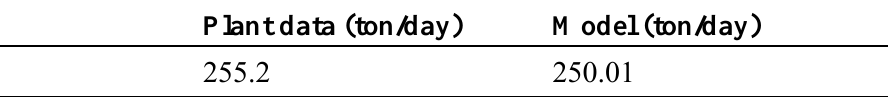
Table 2. Comparison of steady state model and industrial reactor